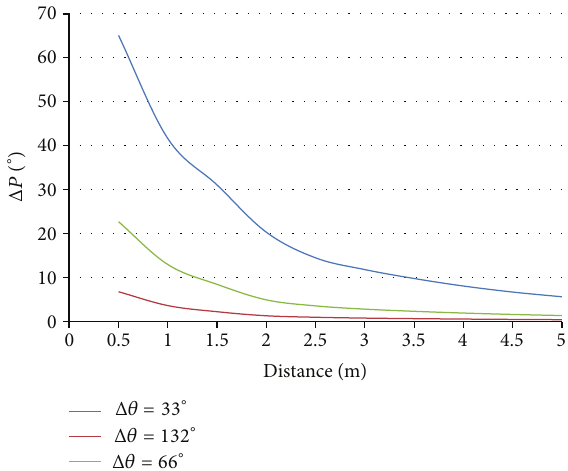
Figure 14: Effect of the half power beamwidth ( Δ𝜃Δ𝜙 ) on the phase variation for increasing distances 𝐷